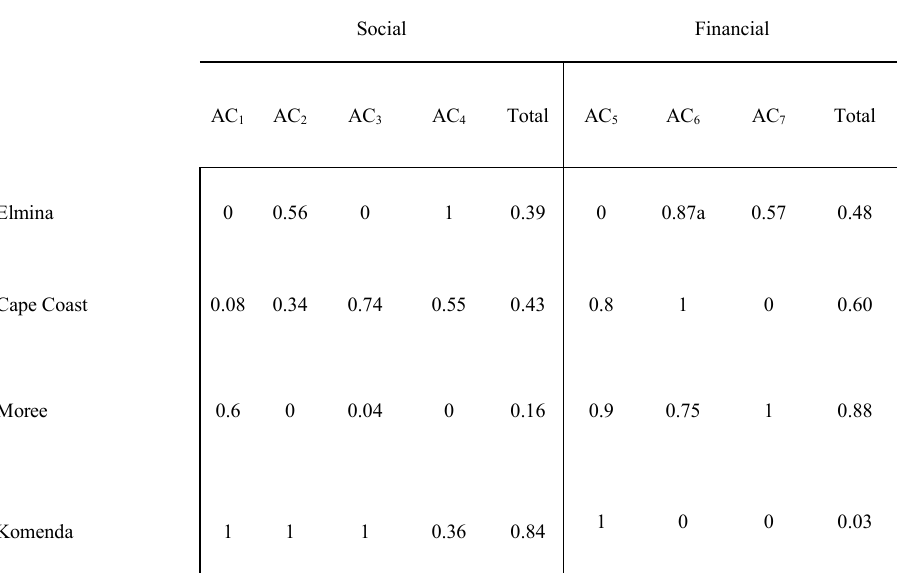
Table 4: Score of adaptation using social and financial capital